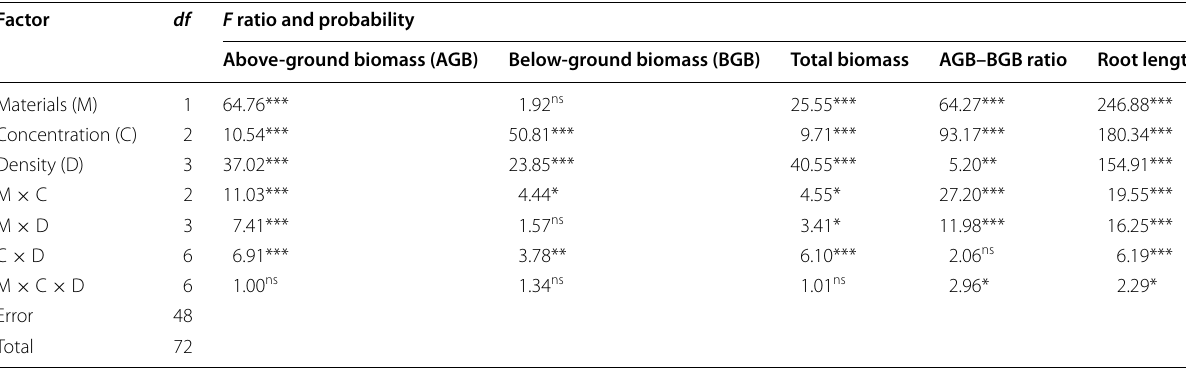
Table 3 Results of three-way ANOVA ( F -ratios) showing the effects of different materials (unburnt and burnt) (M) with different concentrations (C) of Phragmites australis litter extract on growth of Lactuca sativa seedling densities (D)